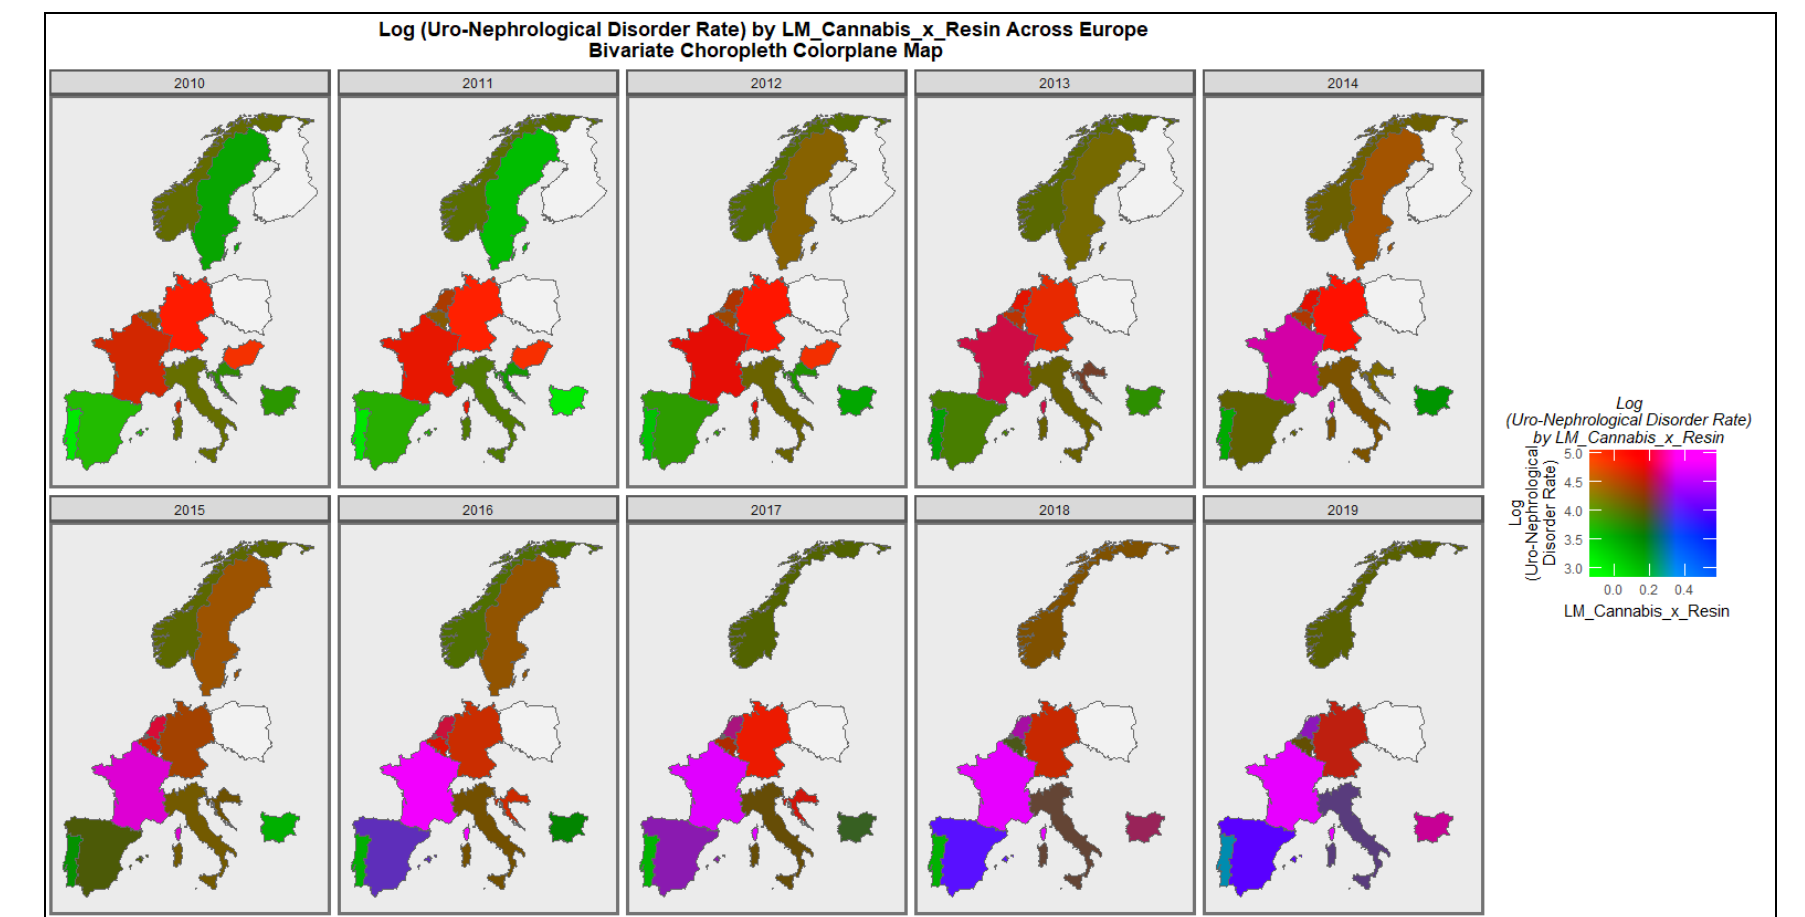
Figure 8. Colorplane bivariate time sequential map-graph of log (uronephrological congenital anomaly rate) by last month cannabis use: cannabis resin THC concentration across surveyed European nations over time.